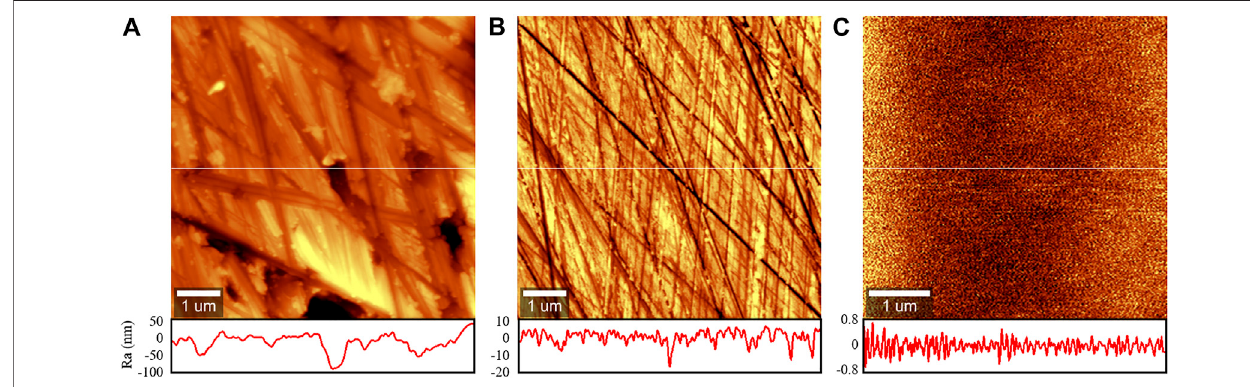
FIGURE 2 | The AFM images of (A) rough grinding, (B) fi ne grinding, and (C) CMP 4H-SiC wafers.